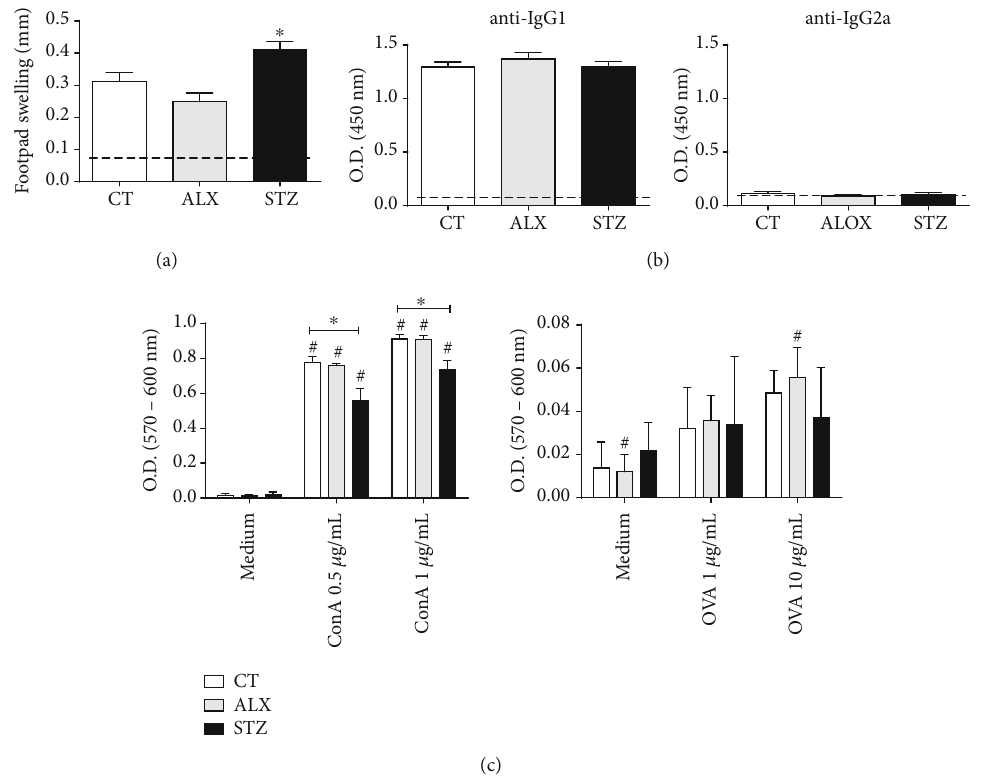
Figure 7: STZ short-term diabetogenic e ff ects promote alterations in immune responses in vitro and in vivo . Mice were immunized with OVA, and 30 days later, T1D was induced as described in Methods. Fifteen days later, (a) antigen-speci fi c paw edema was induced by footpad injection with OVA, (b) OVA-speci fi c anti-IgG1 and anti-IgG2a were determined in the serum, and (c) in vitro spleen cell proliferation was performed by stimulation with medium, Con A (0.5 and 1 μ g/mL — fi nal concentration) and OVA (1 and 10 μ g/mL — fi nal concentration). Dashed line represents the mean of naïve mice not immunized with OVA. Data are presented as mean ± SEM , ∗ p ≤ 0 : 05 (3-6 animals per